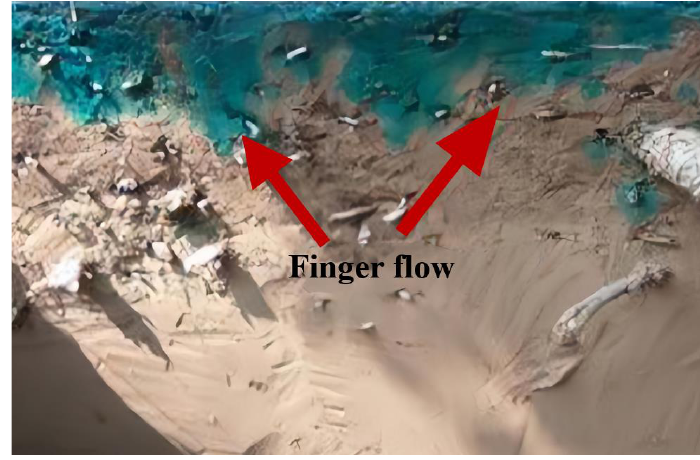
Figure 7. Soil dye profile of Robinia Pseudoacacia community in the study site.